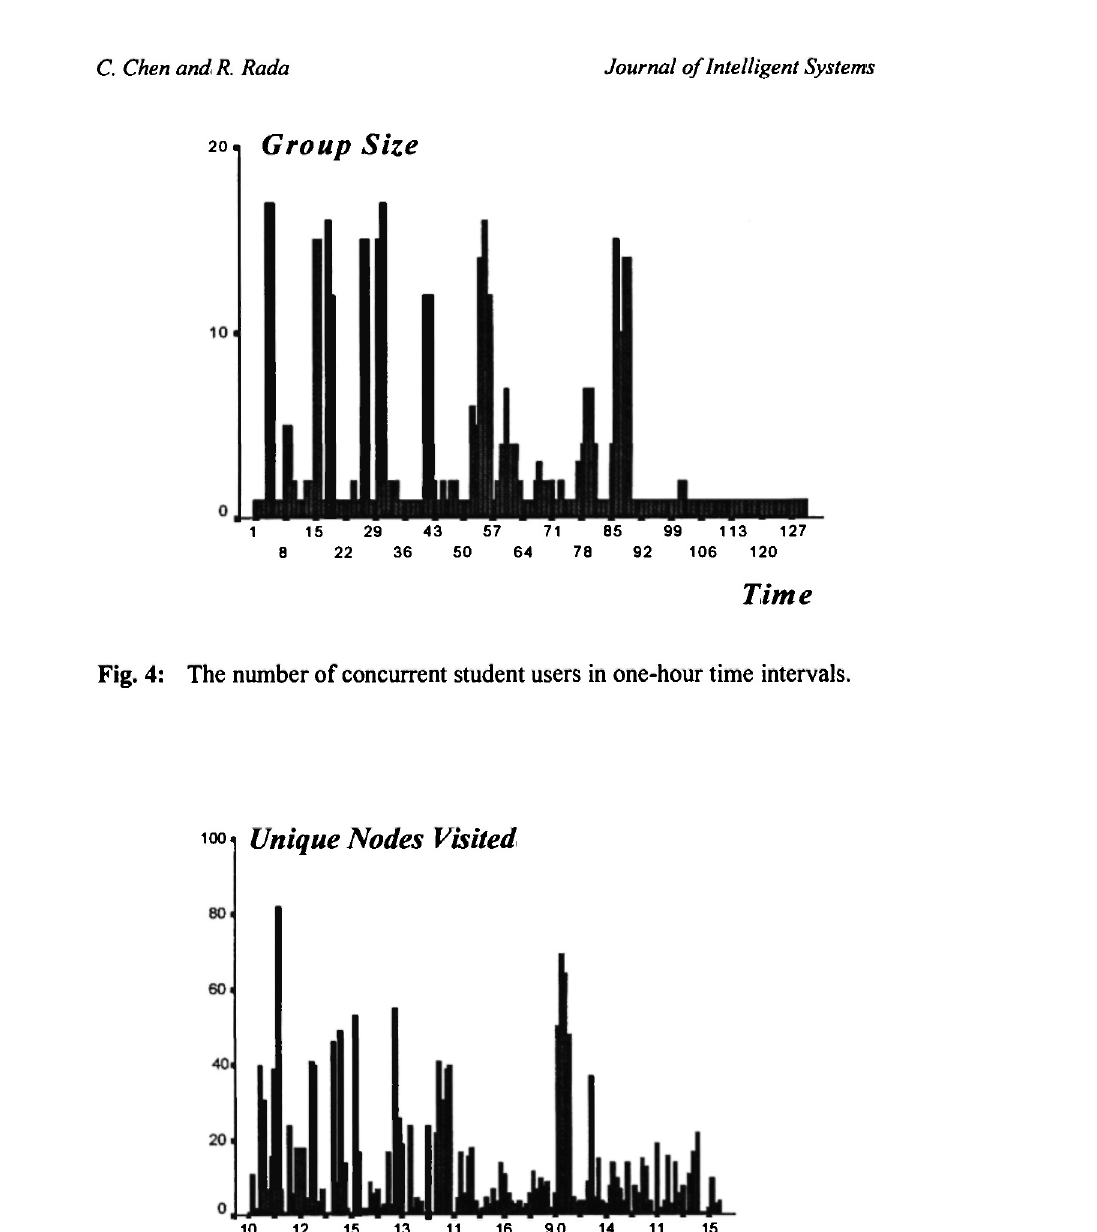
Fig. 5: The number of unique nodes visited in one-hour